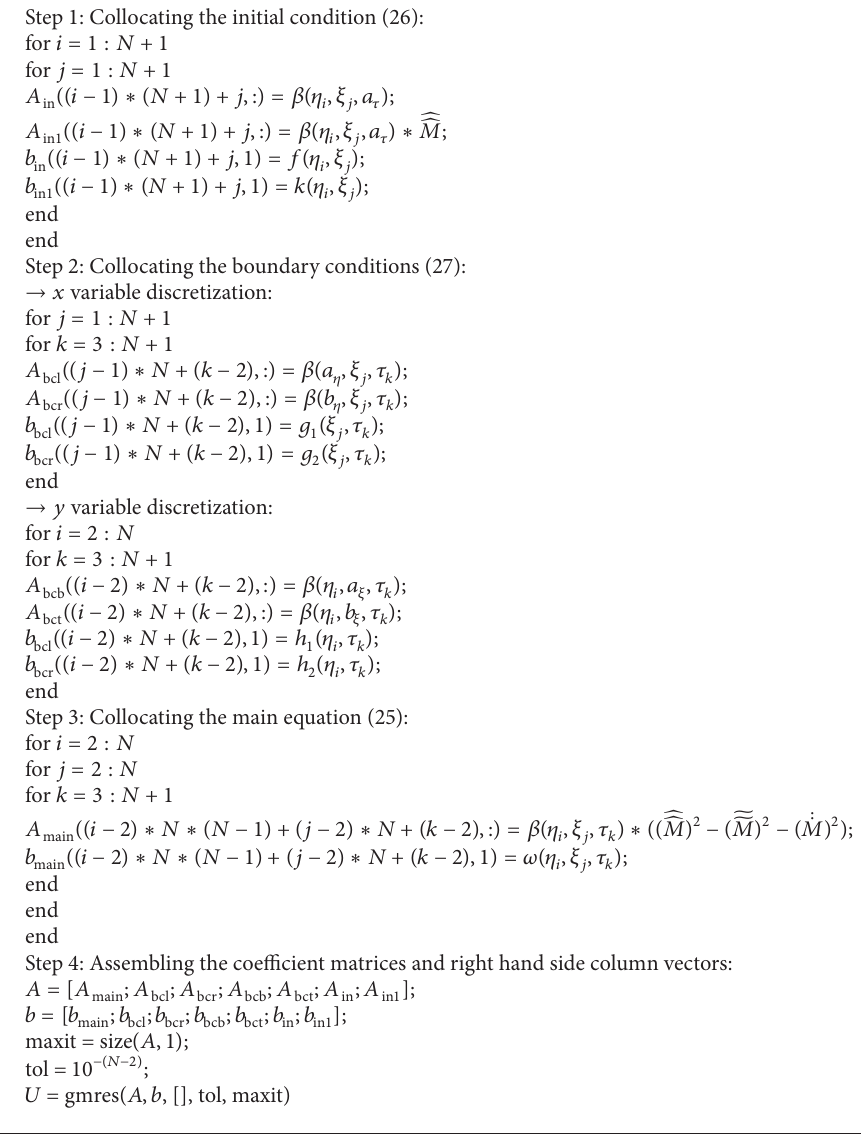
Algorithm 4: Implementation of BCM for solving (25)–(27). Table 1: Numerical results of the BCM and TMM associated with the error 𝑒 𝑁 (𝜂,𝜏) in the second